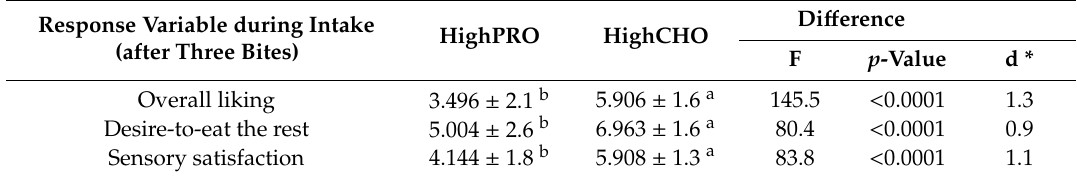
Table 4. Mean ( n = 48) hedonic ratings ± standard deviations of Overall liking, Desire-to-eat the rest and Sensory satisfaction after three bites of the two test meals: High-protein (HighPRO) and High-carbohydrate (HighCHO).